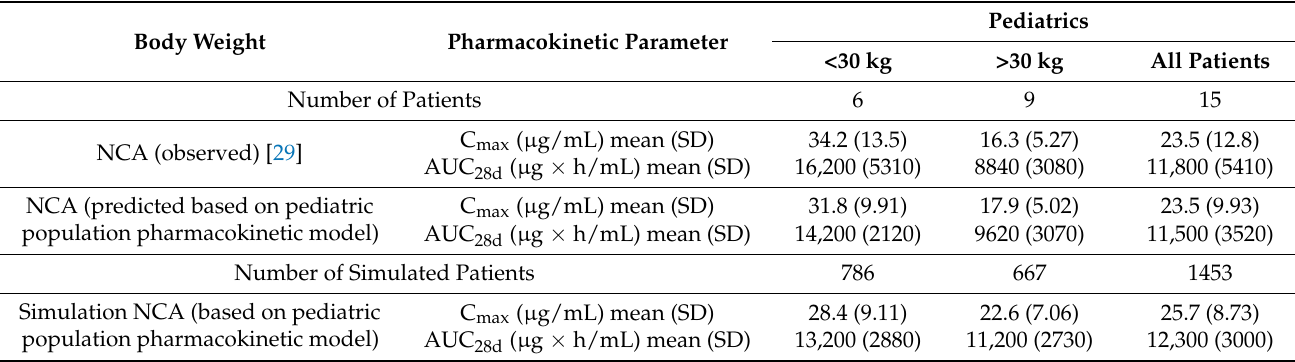
Table 2. Noncompartmental sparse sampling comparison, based on observed and simulated fremanezumab concentrations in pediatric patients receiving a single 75 mg dose of